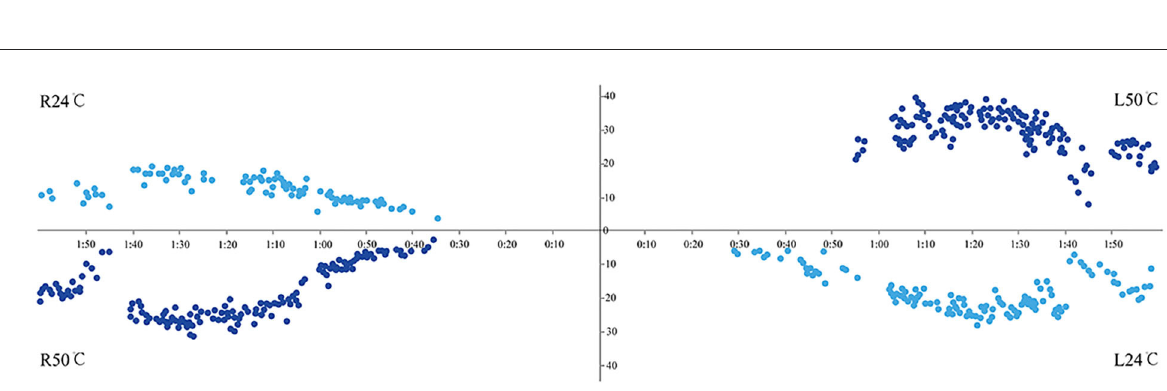
FIGURE2 Normal caloric test showed bilateral symmetry and no absolute caloric hypofunction.